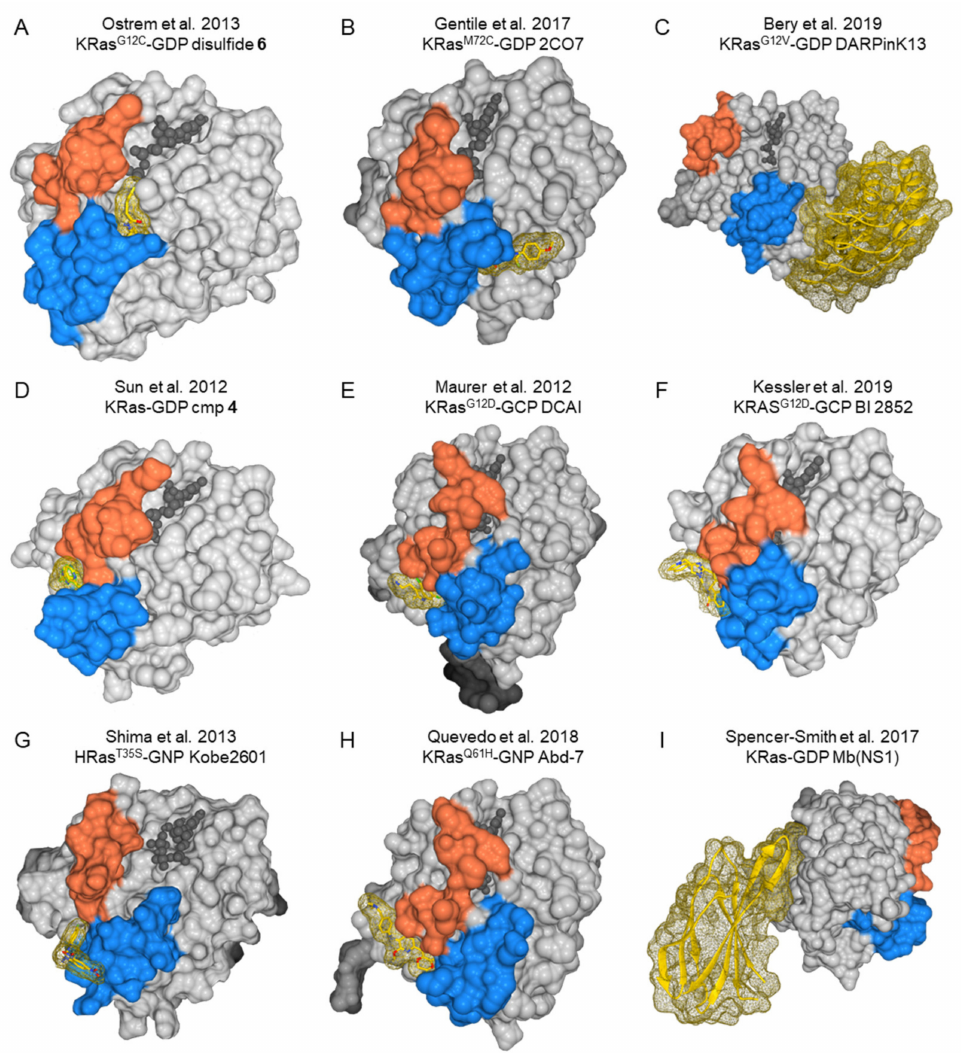
Figure 4. Structures of Ras proteins binding to di ff erent inhibitors. Switch I is in orange, and switch II in blue. Guanine nucleotide is in dark grey balls. Inhibitors are represented as yellow sticks and their surface as a yellow mesh. ( A ) KRas G12C GDP bound to disulfide 6 (PDB ID:4luc) [125], ( B ) KRas M72C GDP bound to 2CO7 (PDB ID:5vbm) [149], ( C ) KRas G12V GDP bound to DARPinK13 (PDB ID:6h46) [151], ( D ) KRas GDP bound to cmp 4 (PDB ID:4epv) [131], ( E ) KRas G12D GCP bound to DCAI (PDB ID:4dst) (Maurer et al., 2012) [131], ( F ) KRAS G12D GCP bound to BI 2852 (PDB ID:6gj8) [139], ( G ) HRas T35S GNP bound to Kobe2601 (PDB ID:2lwi) [137], ( H ) KRas Q61H GNP bound to Abd-7 (PDB ID:6fa4) [138], and ( I ) KRas GDP Mb(NS1) (PDB ID:5e95)